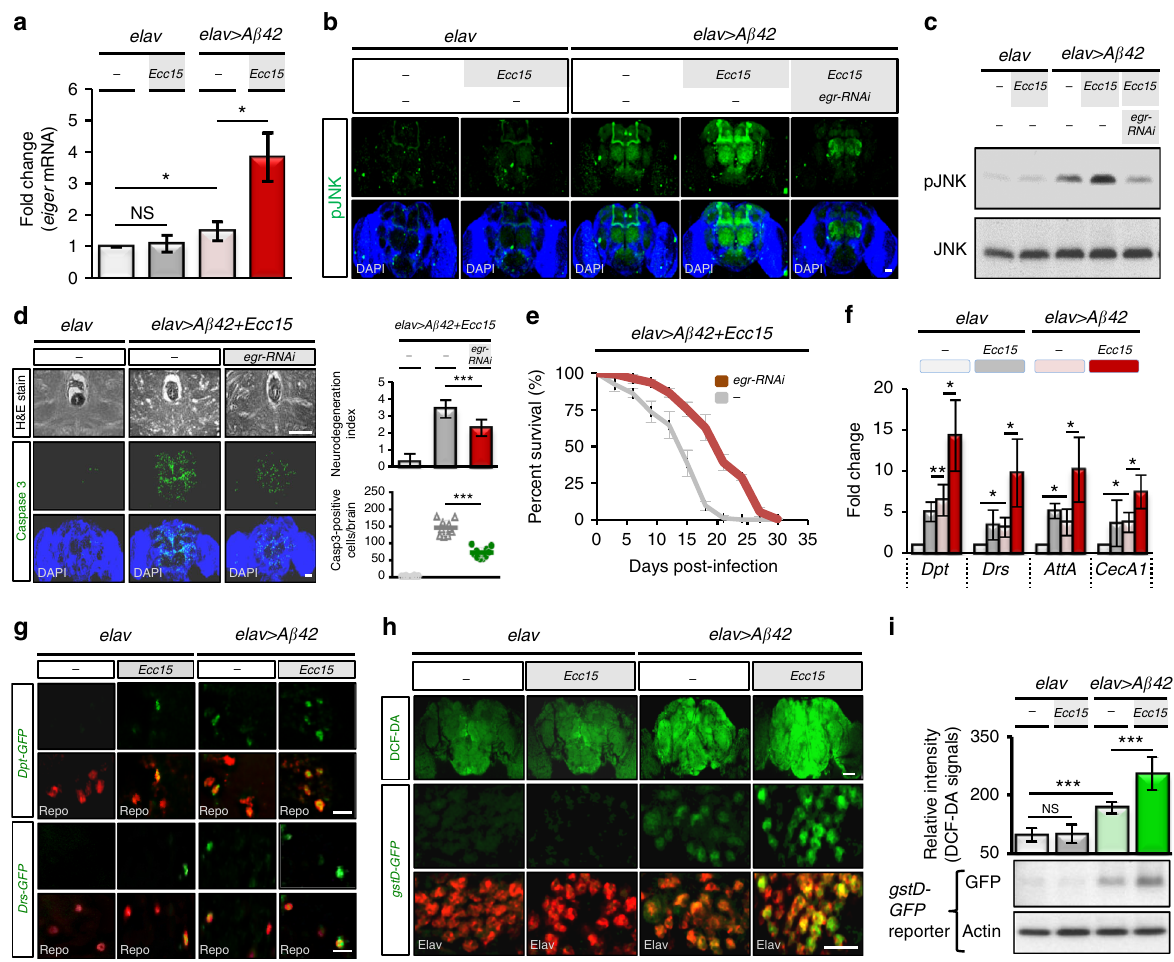
Fig. 2 Enteric dysbiosis remotely triggers in fl ammatory responses in amyloid transgenic fl y brain. a – c eiger expression and JNK activity in brains of amyloid transgenic fl ies with or without Ecc15 infection. eiger mRNA expression analyzed by quantitative RT-PCR (qRT-PCR) a , JNK phosphorylation/activation analyzed by immunostaining b and western blotting c with anti-phospho-JNK antibody. d , e Neurodegeneration d and lifespan e analysis after enteric Ecc15 infection, in Eiger-depleted brain ( elav > egr-RNAi ). f , g qRT-PCR f and confocal microscopy g analysis of brain AMP levels after Ecc15 enteric infection. Repo staining ( red ), glial cells; GFP signals ( green ) of reporter gene expressions in Dpt - and Drs-GFP lines. h , i Brain oxidative stress after enteric infection. Confocal imaging of DCF-DA ( green ) and Elav ( red , neuronal cells) signals h . Quanti fi cation of DCF-DA fl uorescent signals ( upper panel) and western blot analysis of gstD-GFP reporter expressions with anti-GFP antibody (lower panel) in i . elav > A β 42 transgenic or control ( elav alone) fl ies with or without Ecc15 intestinal infection assayed at 10 dpi for eiger expression, AMP response and ROS stress. Error bars represent the SD of at least three independent experiments. * P < 0.05, ** P < 0.01, *** P < 0.001; NS, not signi fi cant. H&E, haematoxylin and eosin. Dpt , Diptericin . Drs , Drosomycin . AttA , Attacin-A. CecA1